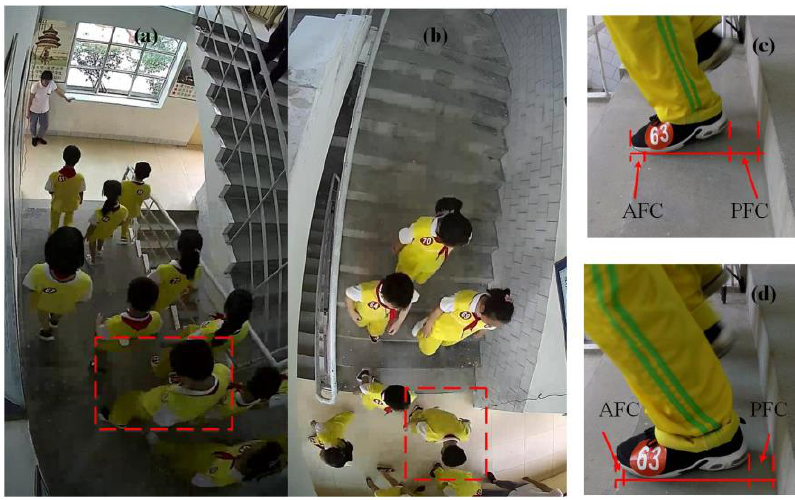
Figure 2. Snapshots of the evacuation process from the top step ( a ) to the ground ( b ) respectively, and the AFC and PFC on the 4th step in the ES 1 ( c ) and 2 ( d ).